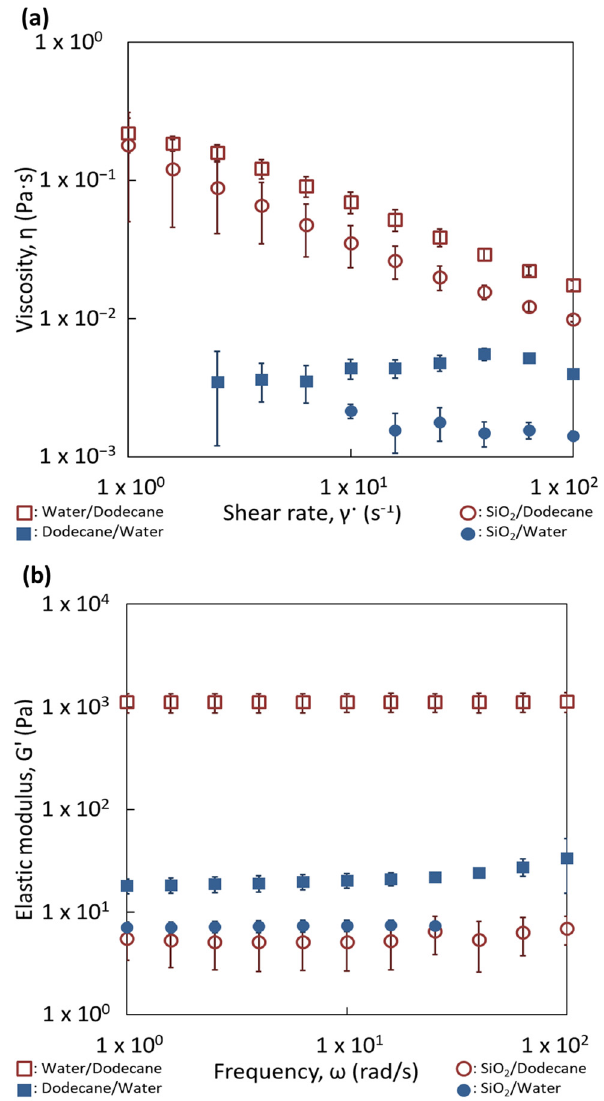
Figure 6. Comparison of the rheological behavior of reverse and direct emulsions prepared with dodecane with ( a ) 1 wt.% and ( b ) 4 wt.% of partially hydrophobic silica particles. ( a ) Flow curves. ( b ) Mechanical spectra.